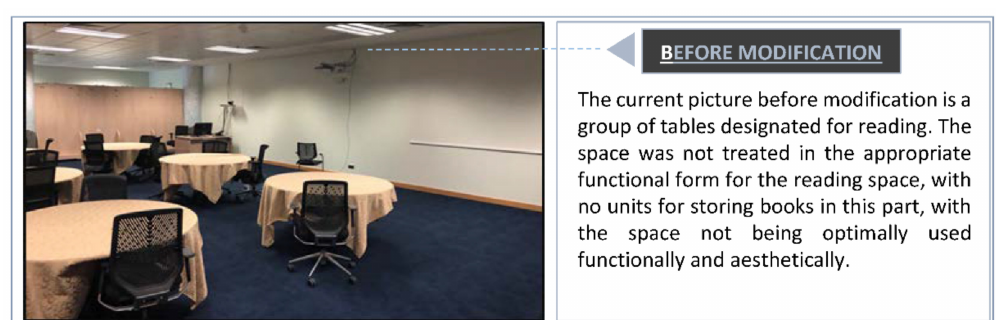
Figure 15. The interior design of the reading space before modification. The reading and borrowing space have been modified by removing the wooden divider and adding storage units for books with a modern design that matches the interior design and used furniture pieces as Figure 16. In addition to providing the reading part with rectangular glass tables, the distribution of internal lighting was taken into account, which achieves comfort for users as Figures 17 and